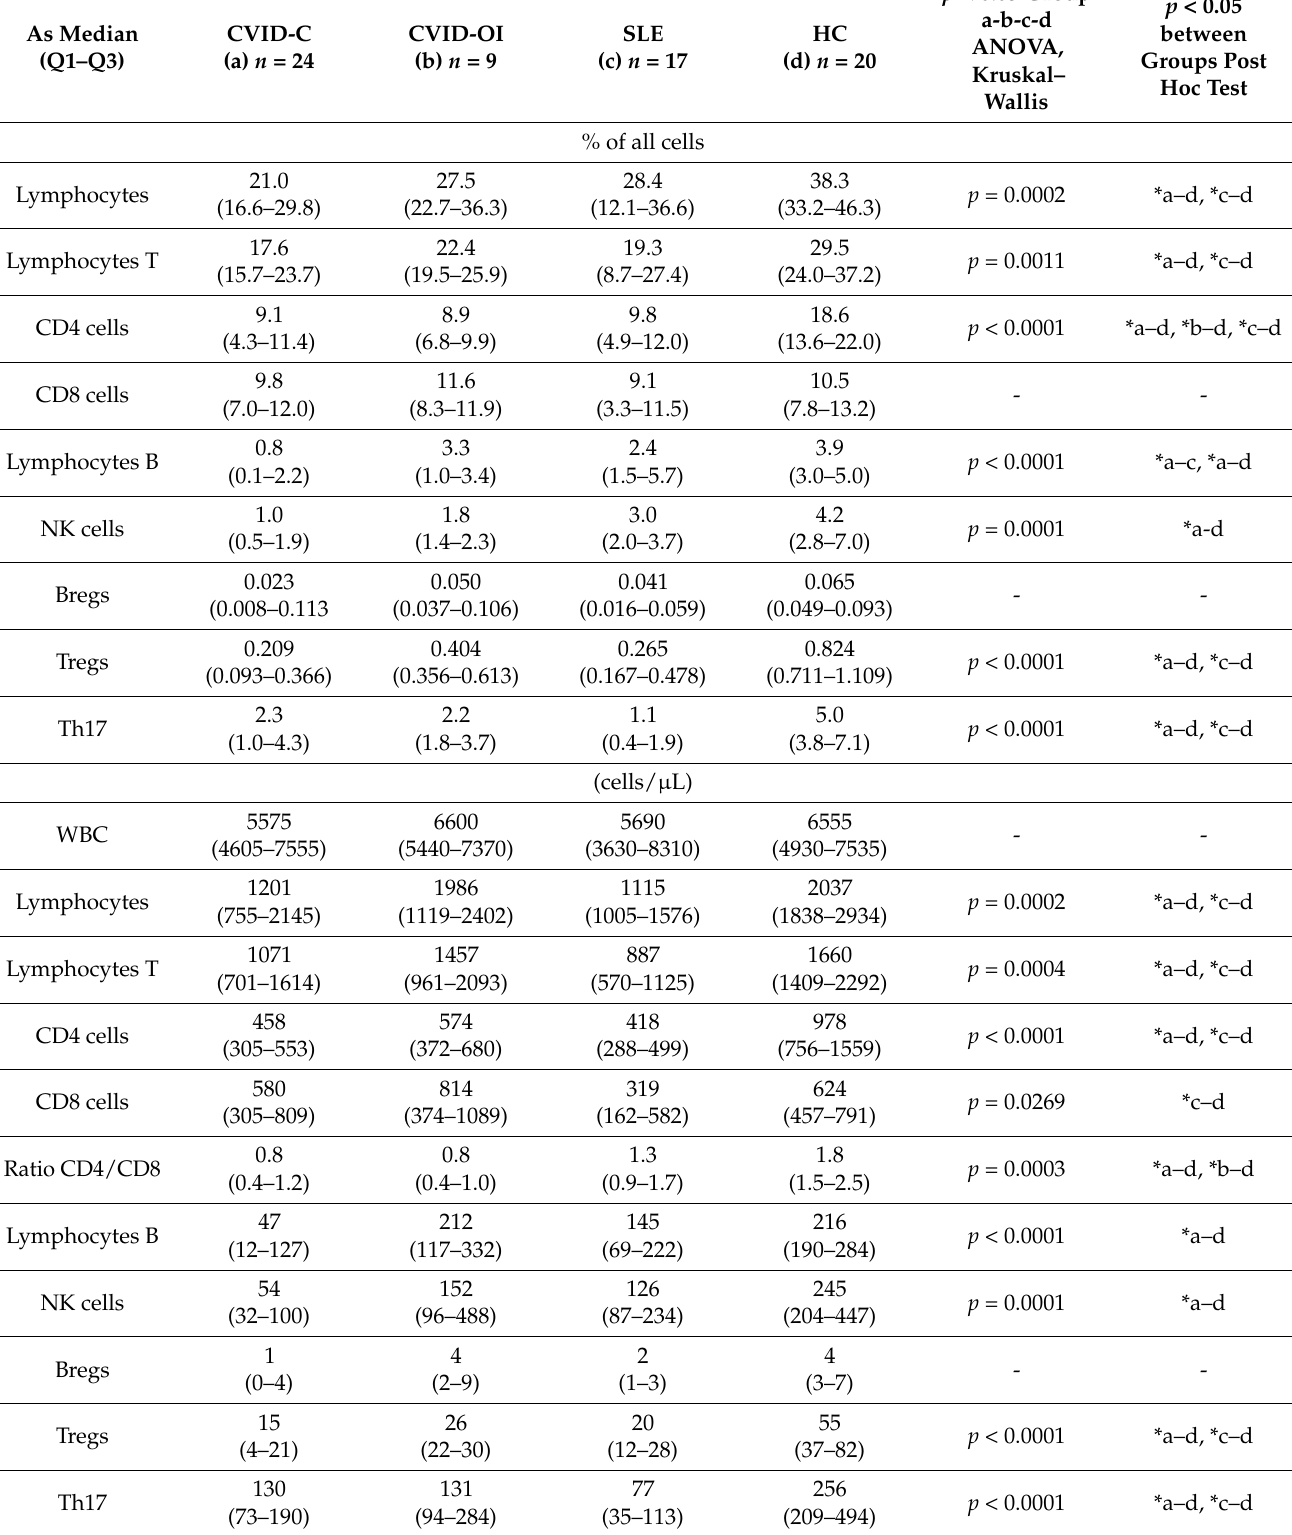
Table 2. Differences in the median of lymphocyte subpopulations and absolute numbers between (a) the CVID with complicated phenotype (CVID-C) group, (b) CVID phenotype limited to only infections (CVID-OI group), (c) patients with systemic lupus erythematosus (SLE), and (d) healthy controls (HCs). Data expressed as median (Q1–Q3). * p < 0.05. ANOVA: analysis of variance, Post Hoc: post hoc analysis